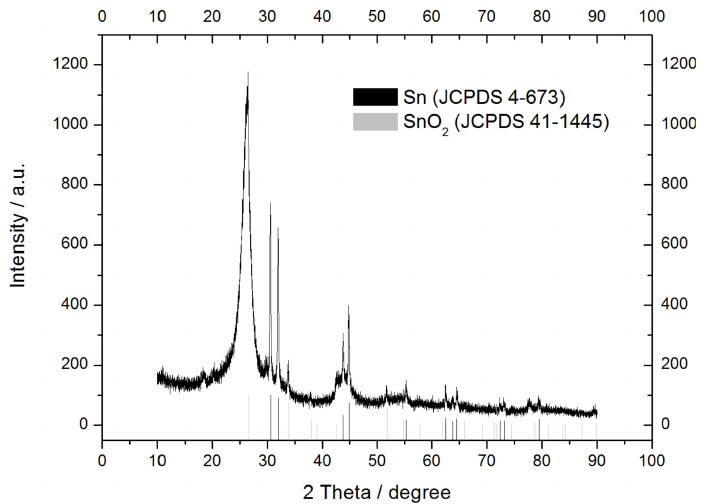
Figure 4. X-ray diffraction (XRD) patterns of the Sn-RGO. Black and gray lines represent the position and intensity of the tin and tin oxide diffraction peaks, respectively.